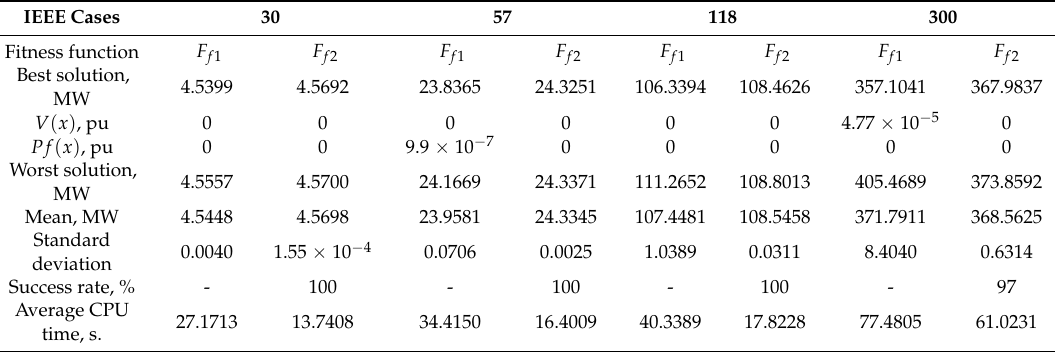
Table 9. Statistical results for power loss minimization for different IEEE power systems based on 100 trial runs.